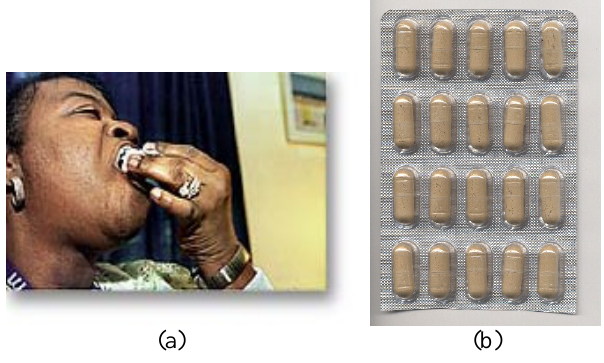
Figure 5: a) Eating clay; b) Loesss (wind-blown sand) pills produced in